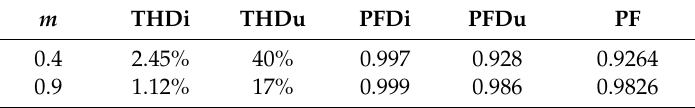
Table 4. Simulated power factor and power factor displacement.